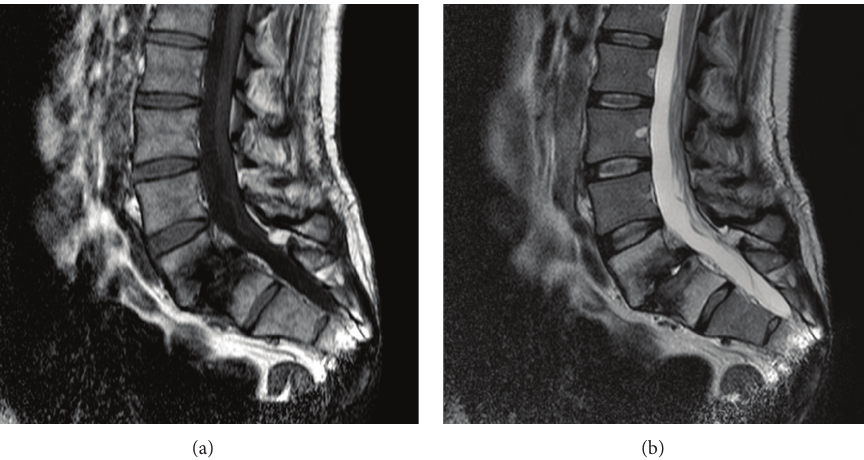
Figure 1: T1 (a) and T2 (b) sagittal lumbar MRI showing an L5/S1 severe discopathy with meyerding grade I listhesis and Modic type 3 sign.